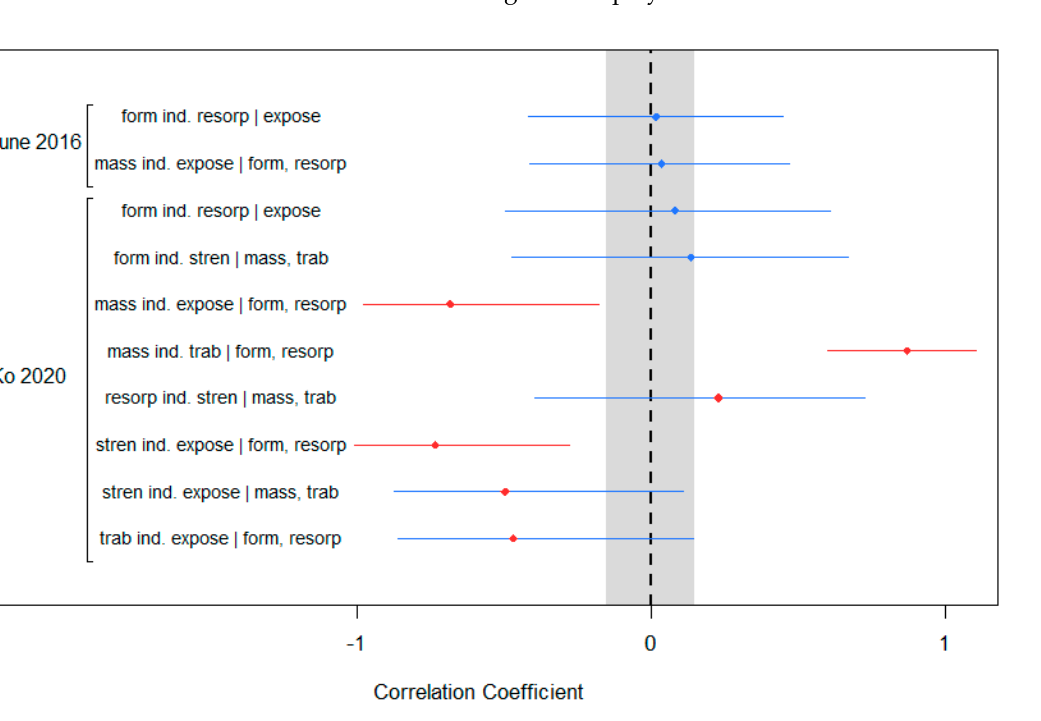
Figure 3. Partial correlations and 95% confidence bands for testing conditional independencies. The grey band represents the no-effect zone, or the zone in which a point estimate is considered indistinguishable from zero. Blue points are those that lie inside the grey band and thus are considered to have zero correlation. Red points are those that lie outside the grey band and thus are considered to have non-zero correlation. Blue interval bands include 0 and red bands exclude 0.